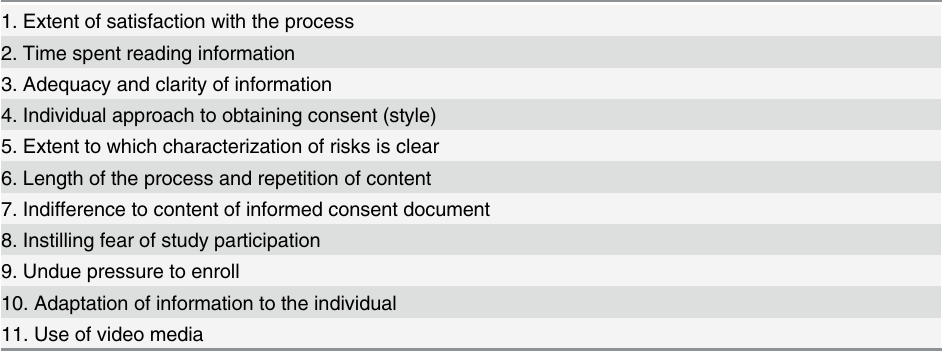
Table 2. Sub-themes identified relevant to invitation, informed consent and participant information